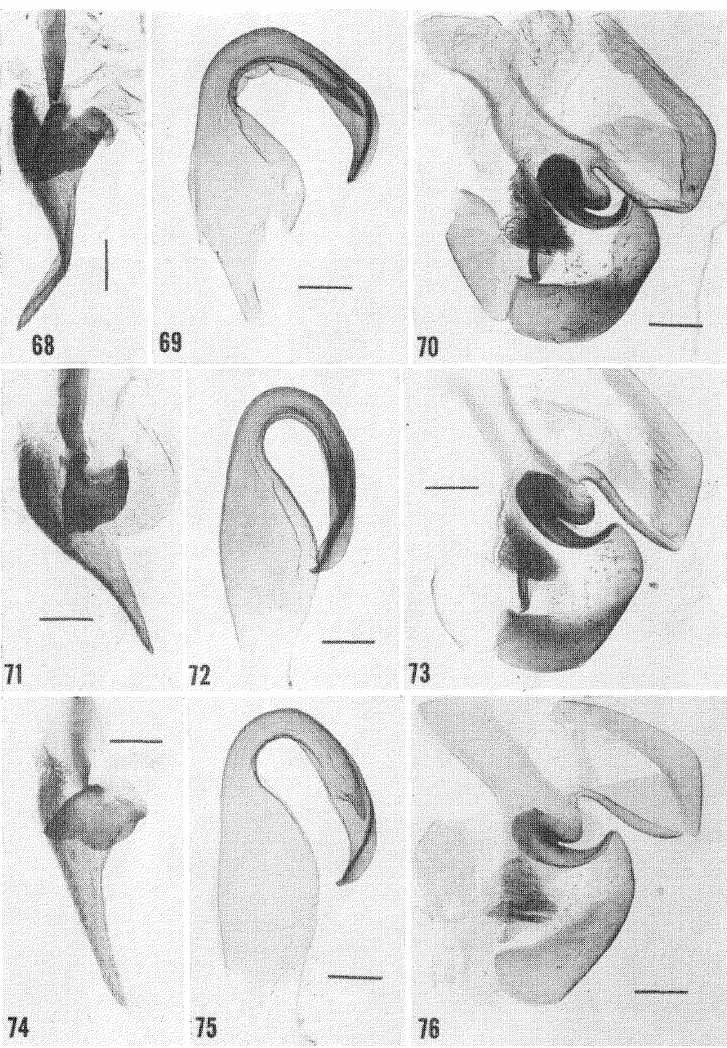
Figs. 68-76. Cockroach male genitalia. Epilampra grisea. 68-70. (42 ANSP). Bartica, British Guiana (det. Hebard). 71-73. (34 AMNH). Surinam (labeled E. lucifuya Rehn, a synonym ot: yrisea). 74-76. (157 USNM). Rosario, Lake Rogagua, Bolivia (det. Roth). (scale 0.2